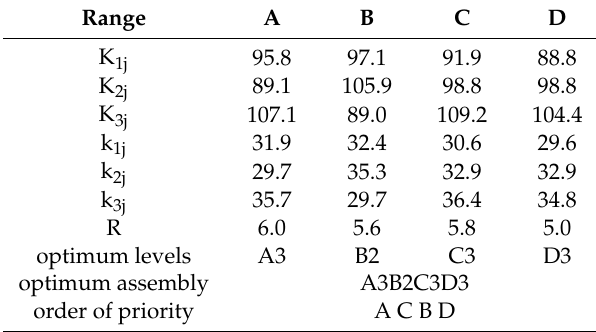
Table 4. Range analysis of tensile strength.